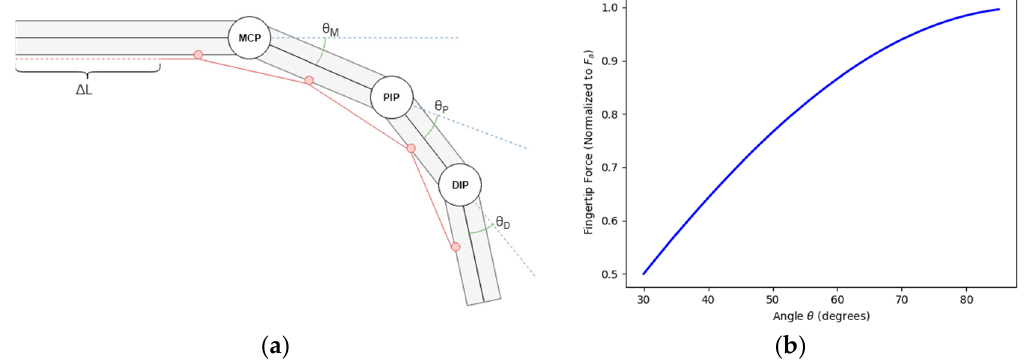
Figure 2. ( a ) Joint control diagram. ( b ) Fingertip force vs. angle of distal phalange